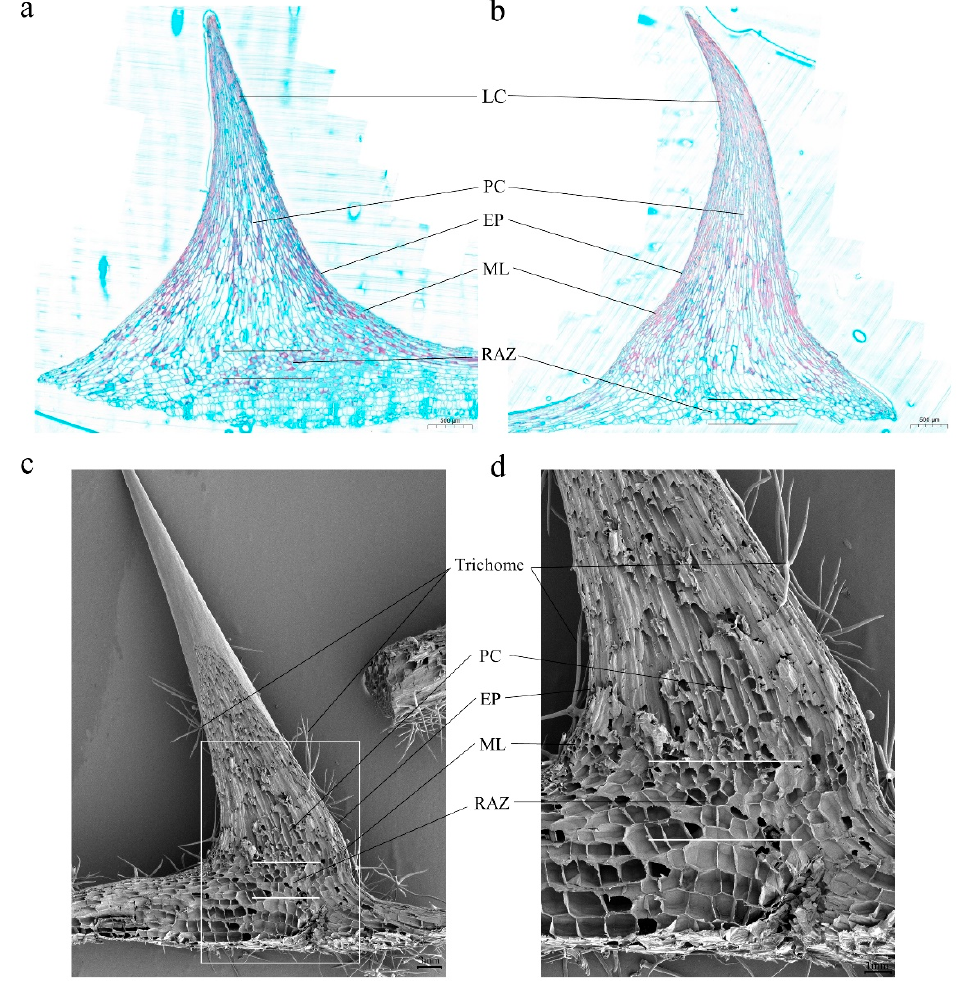
Figure 2. Micrographs of the structures of prickles. ( a ) Semi-thin section and Safranin O/Fast Green staining of longitudinally sliced developing prickles; ( b ) Semi-thin section and Safranin O/Fast Green staining of longitudinally sliced matured prickles; ( c ) Scanning electron micrographs of longitudinally sliced matured prickles; ( d ) Enlarged view of the area outlined by the white square in the graph ( c ). LC, Lignified Cell; EP, Epidermis; ML, Meristematic Layer, PC, Parenchyma Cell; RAZ, Resembling Abscission Zone. Bars, 500 µ m in ( a ) and ( b ), 3 mm in ( c ), 1 mm in ( d